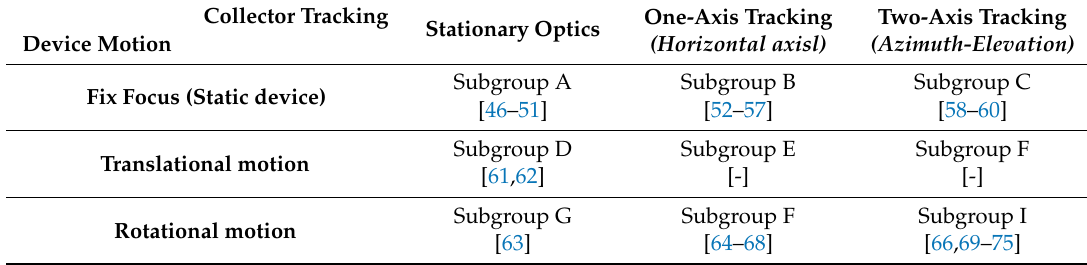
Table 3. Classification matrix of concentrator design concepts identified during literature